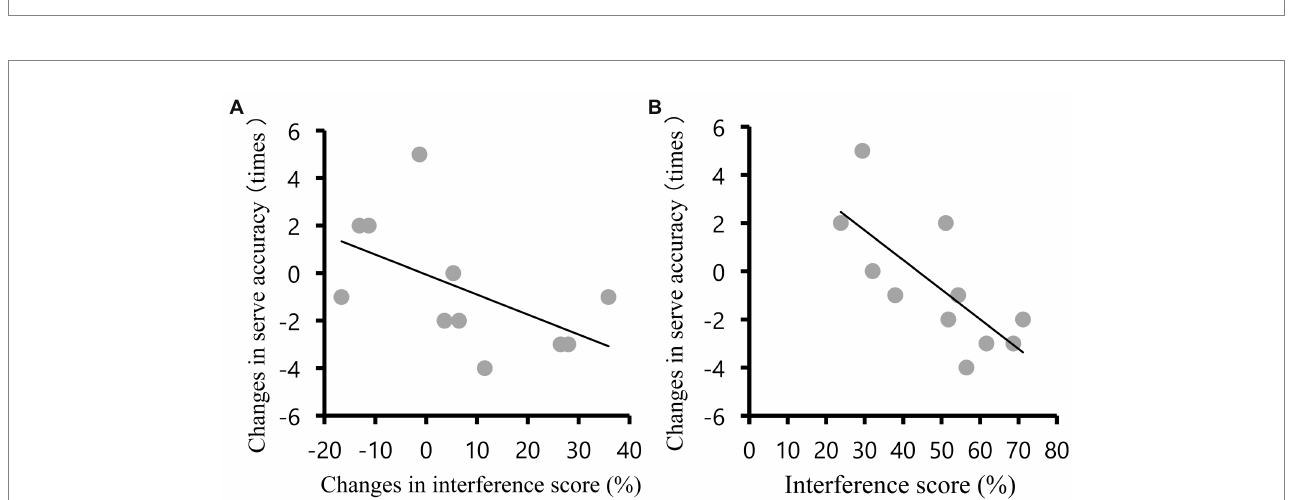
FIGURE 3 (A) The pre-to-post changes in second serve accuracy were negatively associated with the changes in interference score of RT in the posttest ( r = − 0.54, p = 0.08). (B) The pre-to-post changes in second serve accuracy were negatively associated with the interference score of RT in the posttest ( r = − 0.73, p =